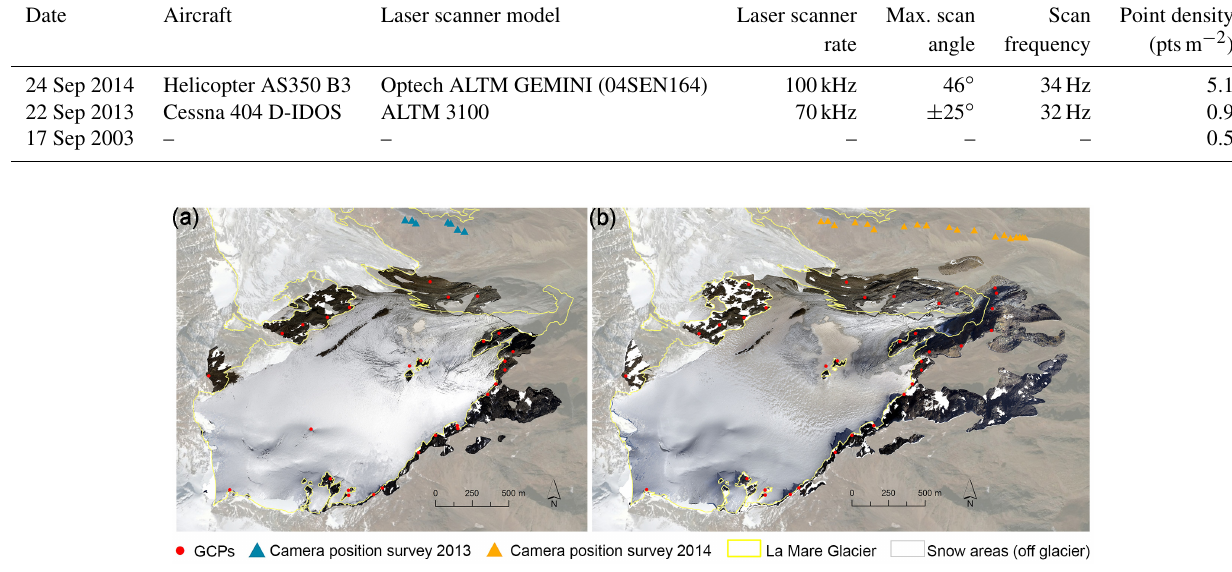
Figure 3. Orthophotos derived from the SfM–MVS 3-D model of La Mare Glacier surveyed on (a) 4 September 2013 and (b) 27 Septem- ber 2014. The white areas in the orthoimages represent the snow-covered area in the rock stable area. The red dots outside the glacier area are the GCPs and the triangles are the identified camera